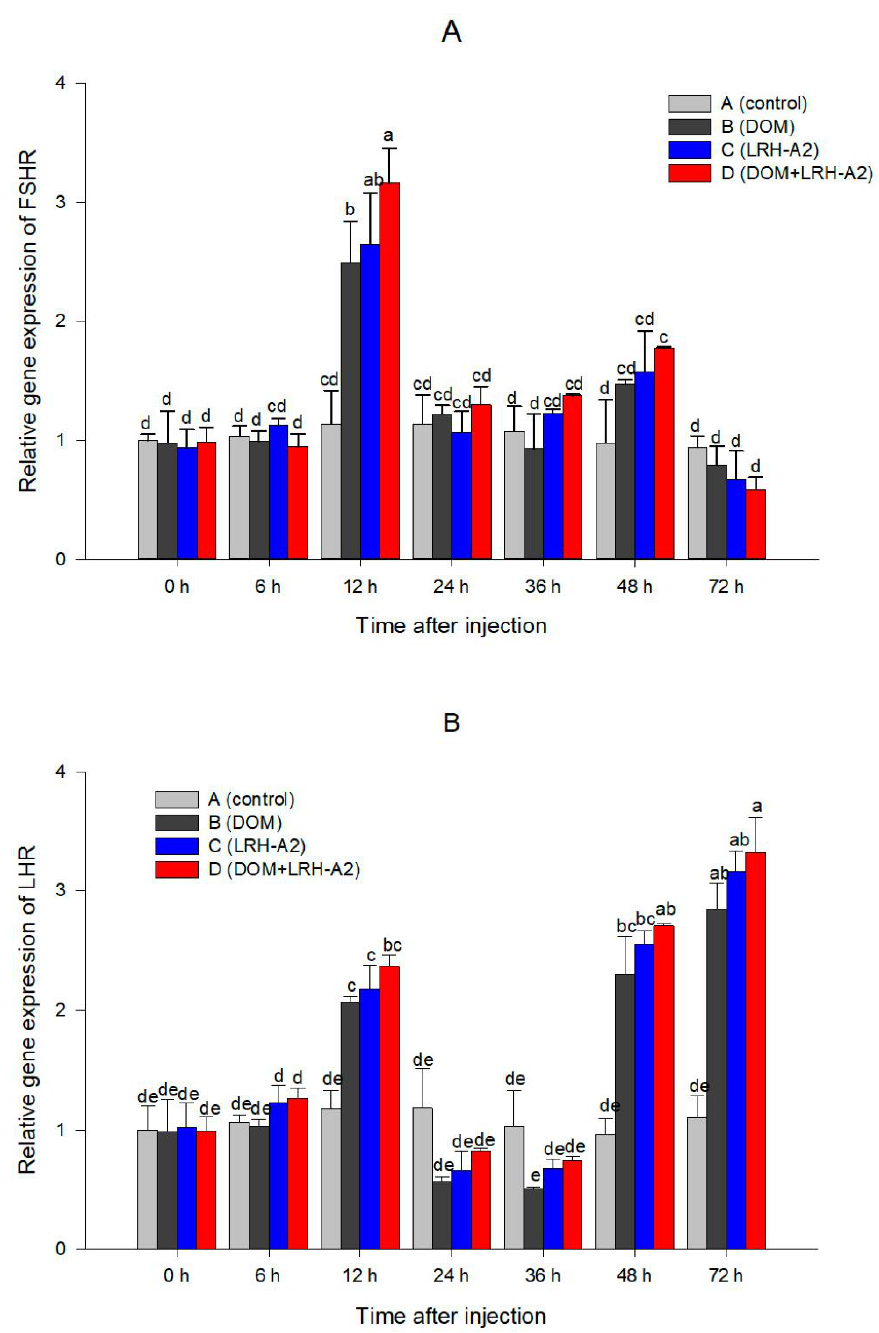
Figure 1. Expression analysis of FSHR gene ( A ) and LHR gene ( B ) in the ovary after injecting different oxytocin. Note: Different lowercase letters represent significant differences between the experimental groups at various time points ( p < 0.05); Reference gene: β-actin ; n = 3.